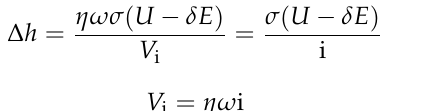
Figure 2. Schematic diagram of electrode system.